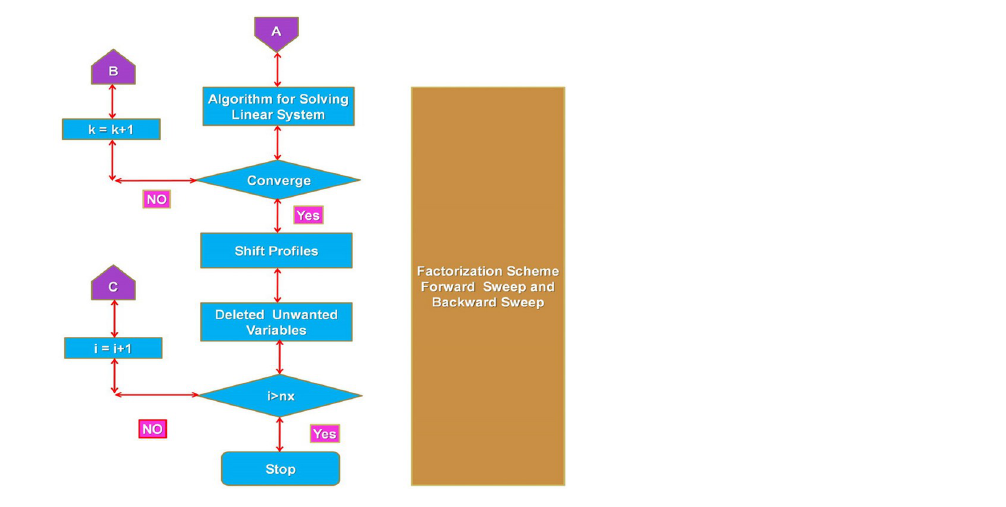
Fig 3. Keller box technique flow chart.